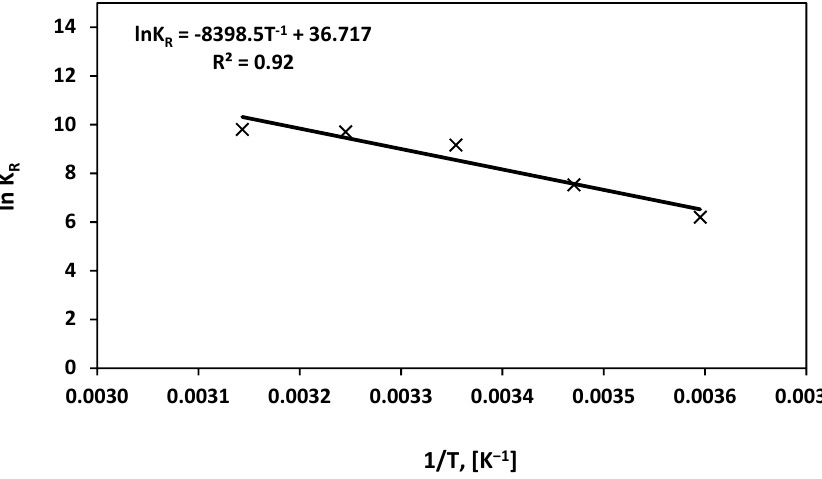
Figure 10. Dependence of the secondary nucleation rate constant 𝐾 (cid:3019) on the reciprocal reaction temperature.